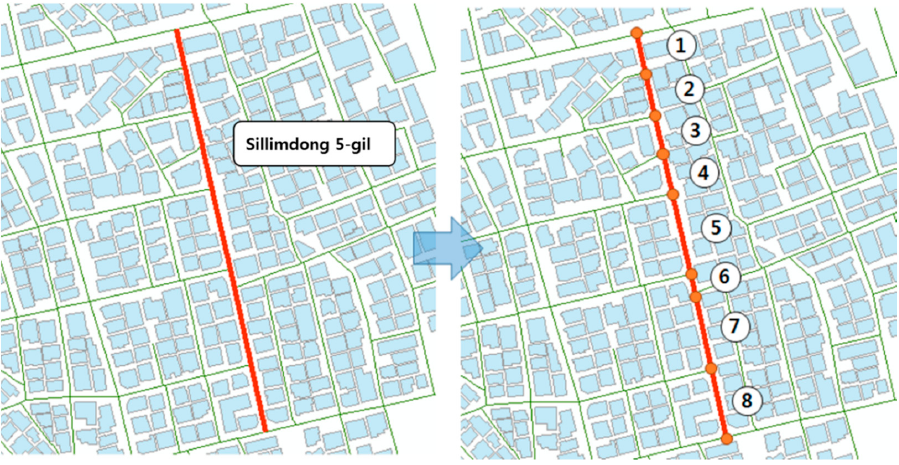
Figure 3. Dividing a road into several road segments.